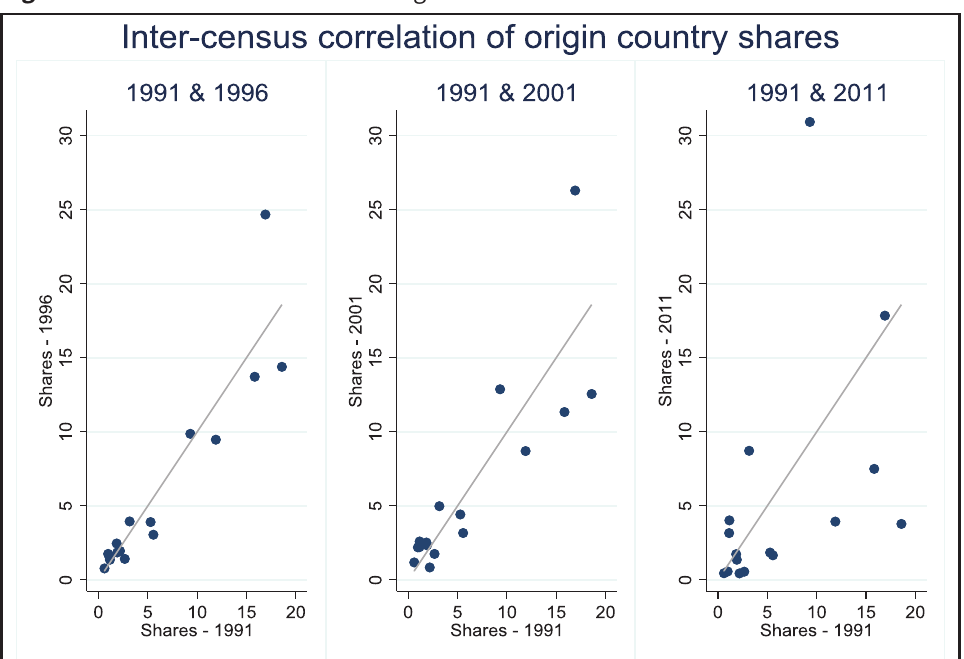
Serial correlation in immigrant